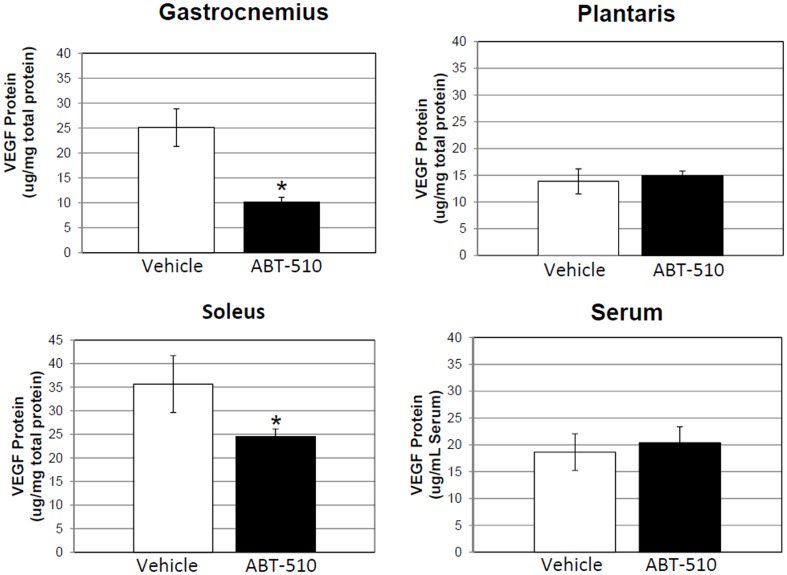
Skeletal muscle VEGF protein content is decreased in the ABT-510 group, but not serum levels.Chronic administration of the mimetic (ABT-510 30 mg/kg/day) decreased VEGF protein in the GA, and SOL muscles of C57/BLK6 mice. There was no change in the PLT muscle or in Serum levels. * = P≤0.05.